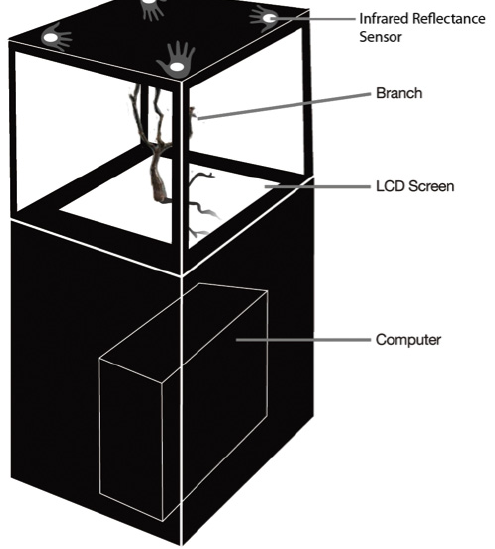
FIGURE 4 | The system map of the installation.